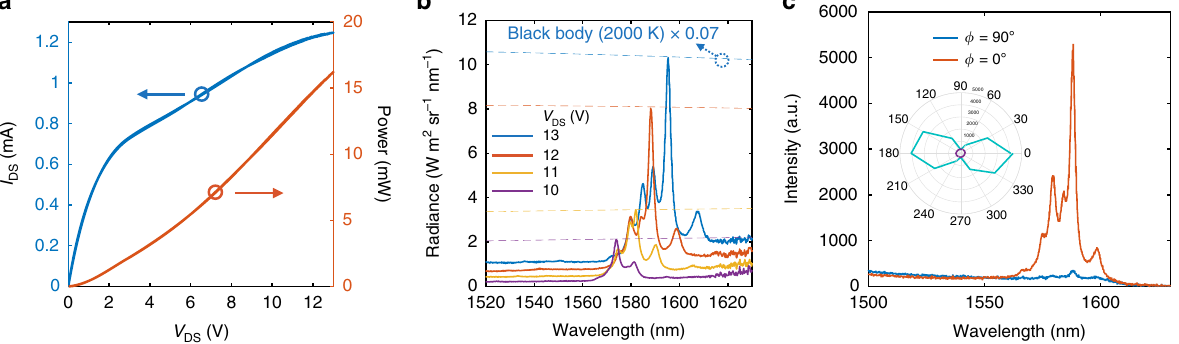
Fig. 2 Thermal radiation properties. a Current – voltage (blue) curve of the hBN/graphene/hBN emitter. The red curve corresponds to the electrical power that is applied to the graphene emitter. b Emission spectra of the graphene emitter at different V DS voltages. The dashed reference blackbody emission spectra at 2000K (blue), 1930 K (red), 1640 K (yellow), 1510 K (purple) serves to compare with the emission of the graphene emitter. c The emission spectra of the graphene emitter at polarization angles of ϕ = 0° (red) and ϕ = 90° (blue) with applied V DS = 13 V. Inset shows the emission intensity with respect to ϕ at wavelengths of 1585 nm (cyan) and 1500 nm (purple)